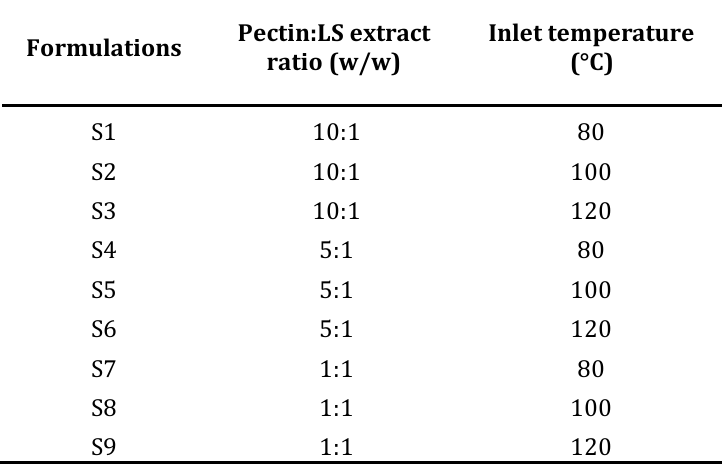
Table 1: Experimental design of LS microcapsules produced by spray-drying. Pectin:LS Formulations